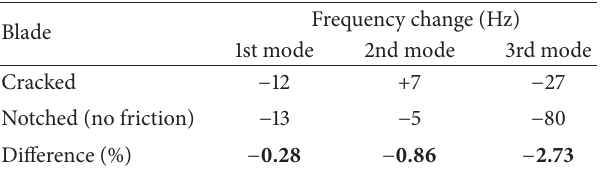
Table 4: Blade with 11mm length damage (starting from TE) placed 20 mm from lock [23,